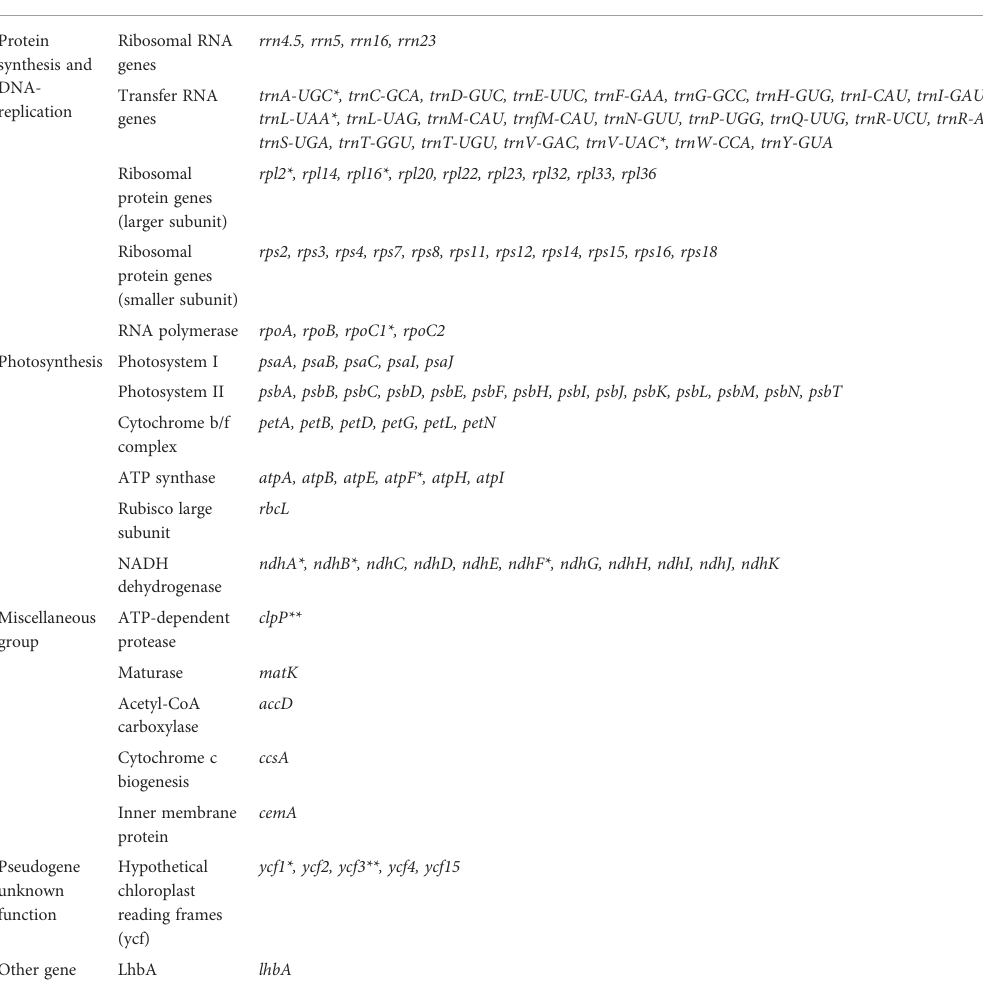
TABLE 3 Genes in the chloroplast genome of twelve Paraboea